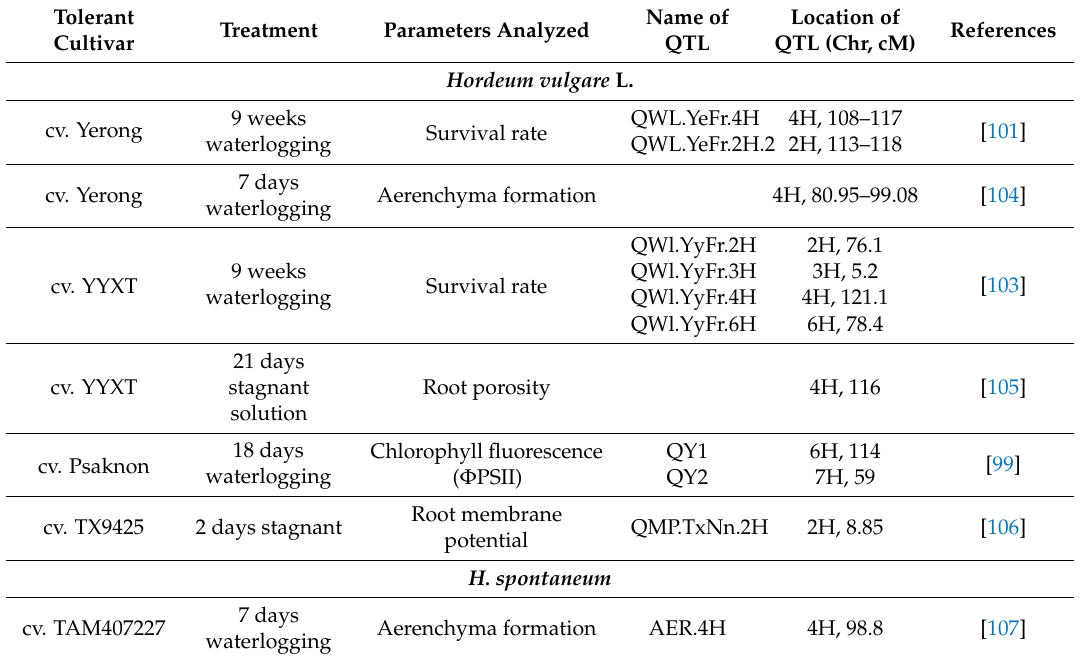
Table 3. Promising QTLs from barley ( Hordeum vulgare ) and related species associated with waterlogging